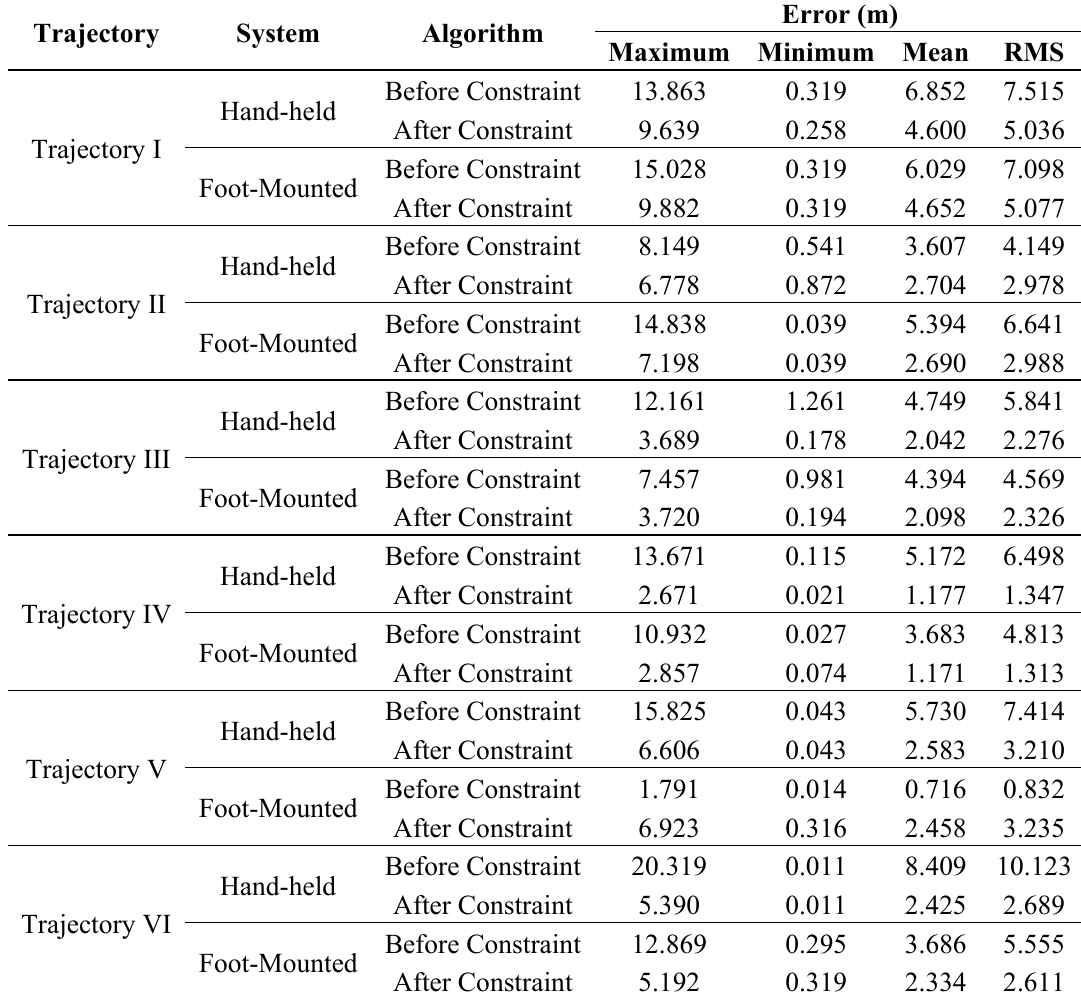
Table 1. Positioning performance using different algorithms in the six different